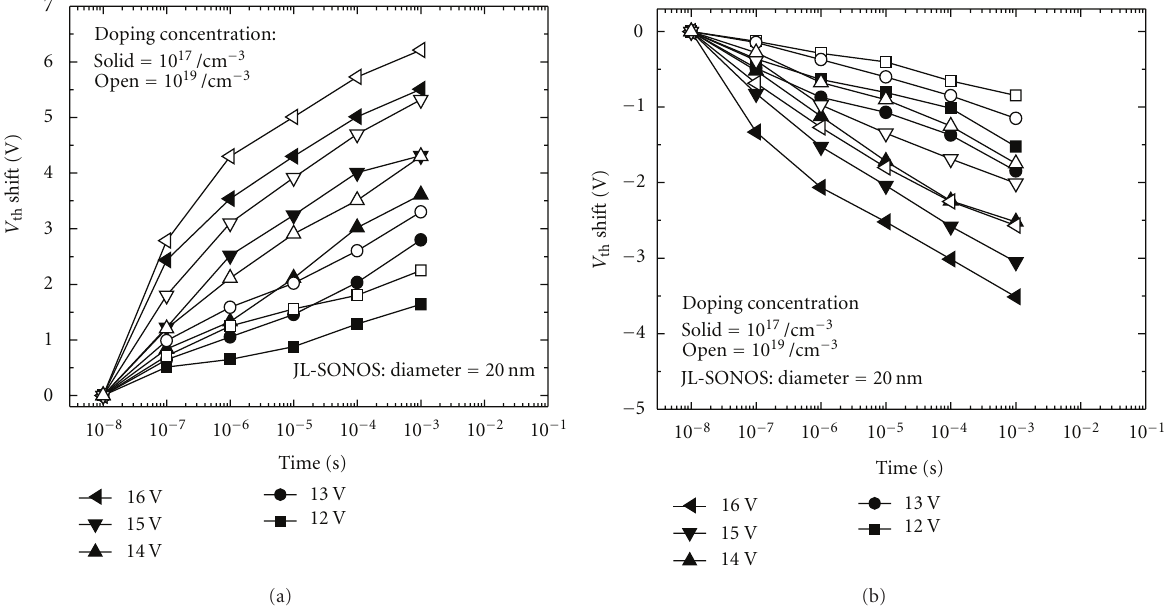
Figure 14: (a) Programming and (b) erasing characteristics using FN tunneling of vertical SiNW-based GAA JL-SONOS memory device with channel doping of 1 × 10 17 cm − 3 and 1 × 10 19 cm − 3 . (Reprinted with permission from [45]. [2011] IEEE.)